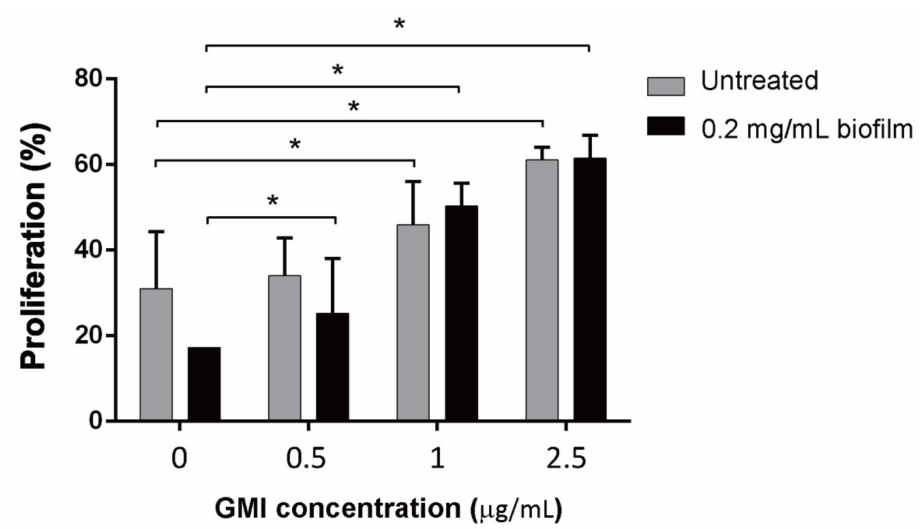
Figure 2. Influence of GMI on the suppression of T cell proliferation by MDSCs. Freshly isolated mouse BMCs were untreated or treated with 0.2 mg/mL S. aureus biofilms for 48 h. MDSCs expanded from BMCs were treated with anti-CD11b antibody conjugated with FITC and anti-Gr1 antibody conjugated with PE. The cells that were bound to both antibodies were separated using a cell sorter. MDSCs were treated with different concentrations of GMI for 24 h and then cocultured with activated CFSE-labeled T cells at a ratio of 0.5:1. The results were analyzed statistically with Student’s t -test. *: p <